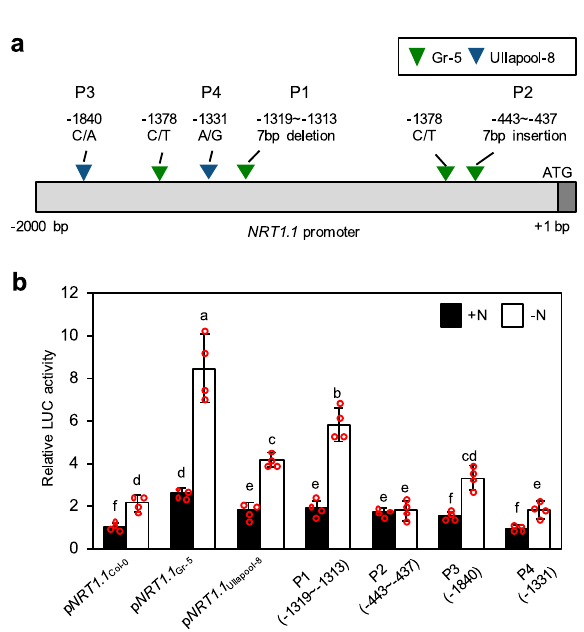
Fig. 7 N de fi ciency-inducible activity of the Col-0-, Gr-5-, and Ullapool-8- type NRT1.1 promoters in Arabidopsis protoplasts. a Structure of the NRT1.1 promoter used in the transient expression assay. Polymorphisms detected in Gr-5- and Ullapool-8-type NRT1.1 promoters using the Col-0- type NRT1.1 promoter sequence as a reference are